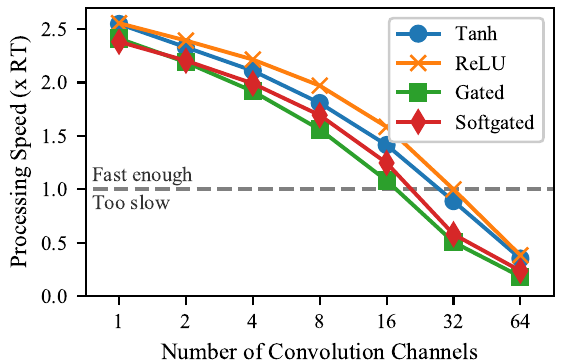
Figure 5. The processing speeds of the 18-layer model with different activation functions and different numbers of convolution channels. The cases above the horizontal dashed line can run in real